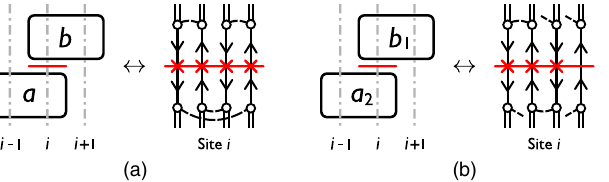
FIG. 15. Examples of contractions in a portion of a site diagram for h exp ½ − S 2 ð t Þ(cid:2)i . Left sides of (a) and (b): Two neighboring blocks along site i shown in the space-time plane with the time axis vertical. Right sides of (a) and (b): Equivalent site diagrams with the time axis vertical; open-ended dashed lines are con- tracted nonlocally with an external block. Red lines represent sections of boundary (of unit length in the left-hand pictures). (a) Right: The boundary crosses four times a loop of length at least 2 at the red crosses, so ω ð a; b Þ ¼ q − 1 . (b) Right: The boundary has three costly crossings, so ω ð b 1 ; a 2 Þ ¼ q − 3 = 4 .